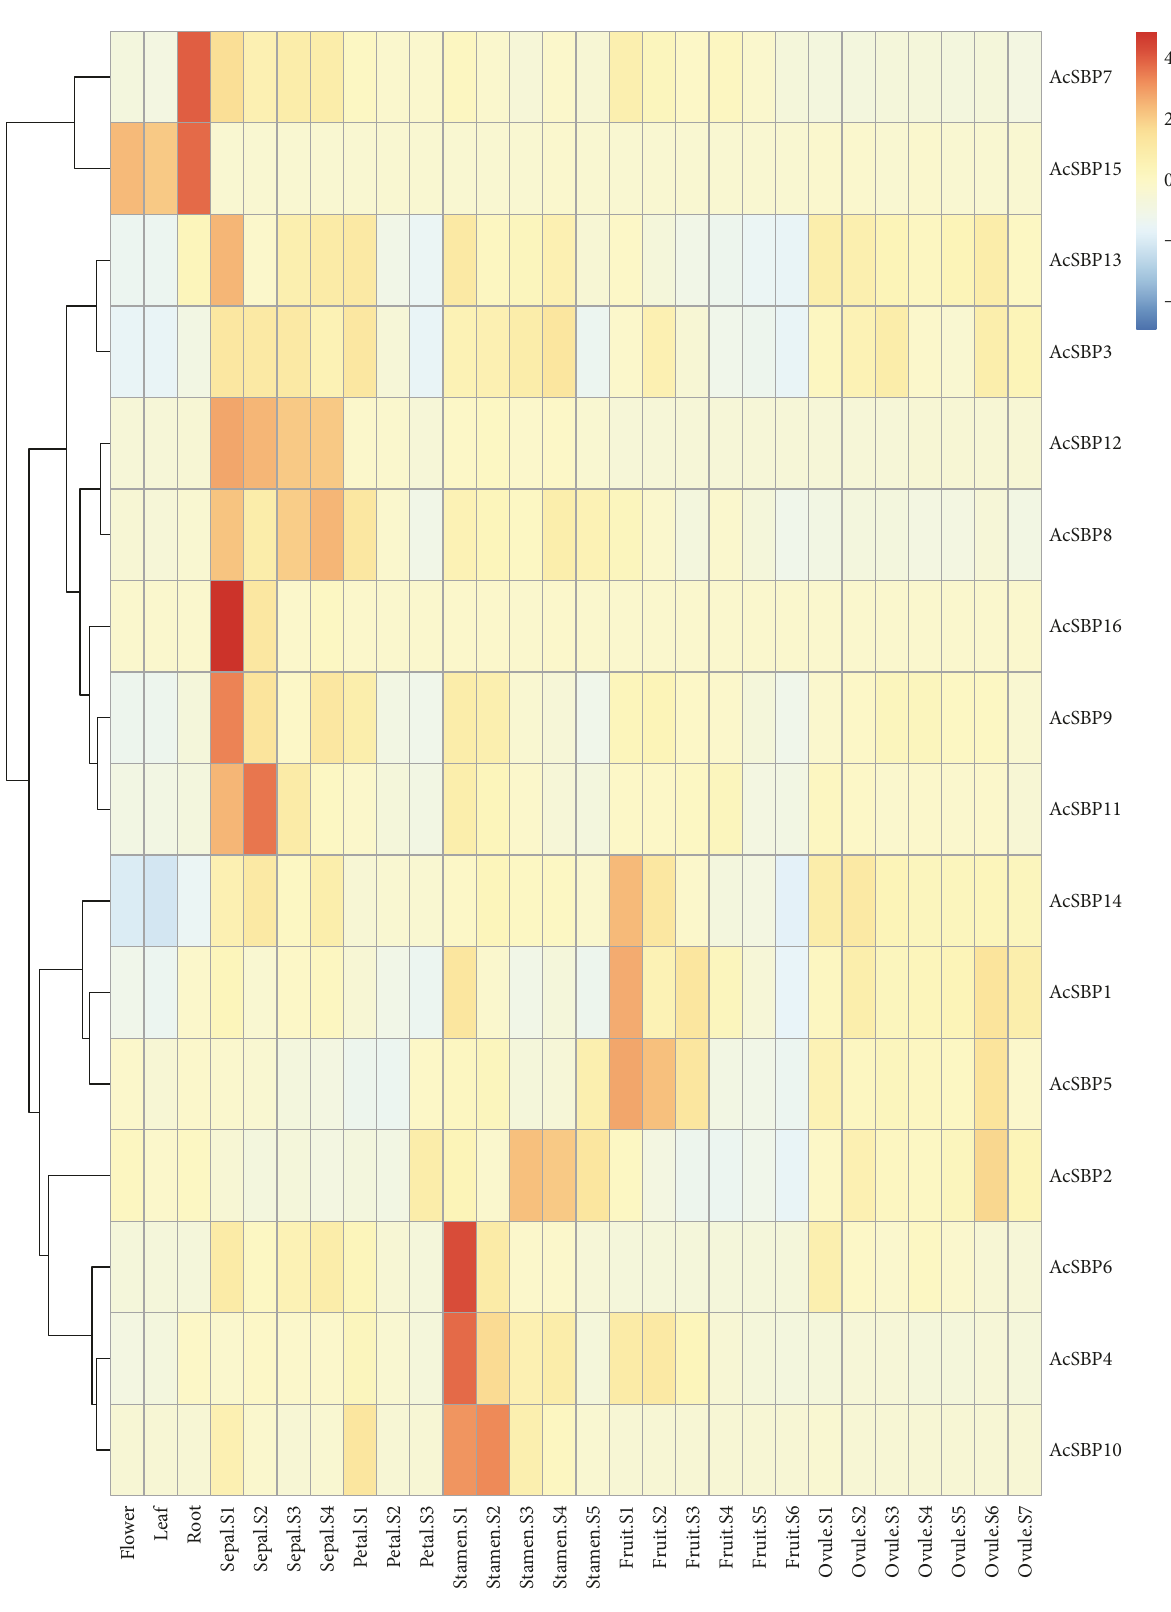
Figure 4: A heat map of tissue-speci fi c expression pro fi le of SBP genes in pineapple. Expression level can be understood using the given